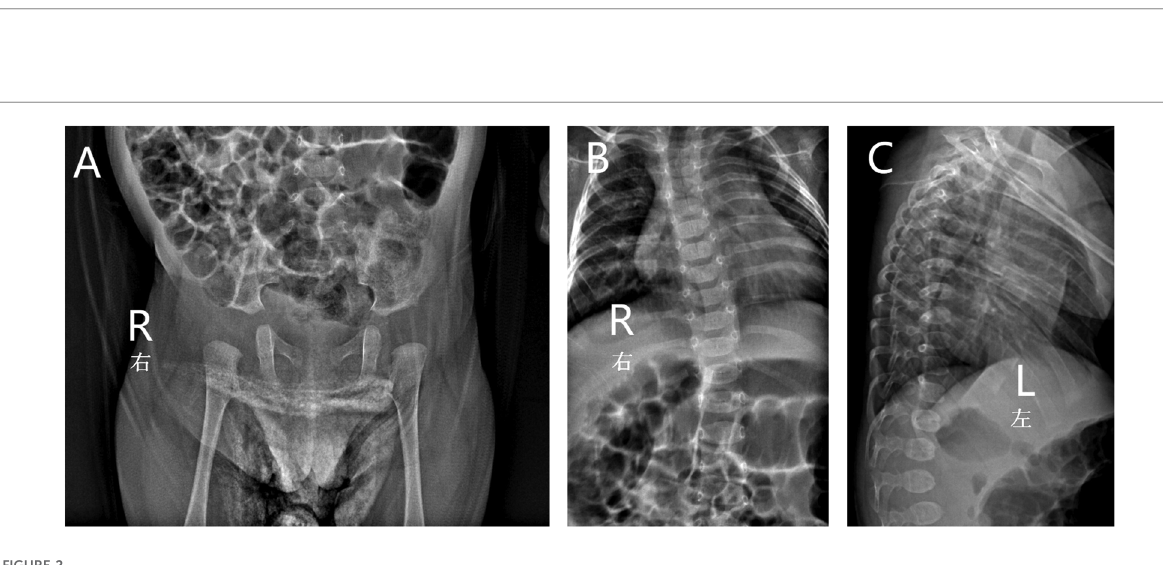
FIGURE 2 X-ray of the patient showed widened right hip joint space ( A ), spinal deformity, dislocation ( B ) and slight kyphosis ( C